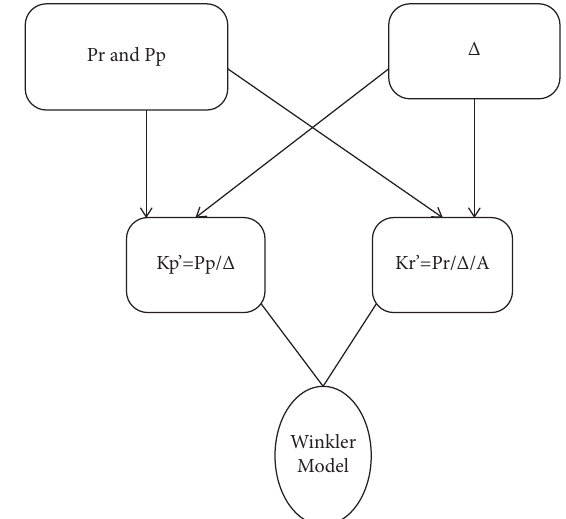
Figure 1: WMPR flowchart